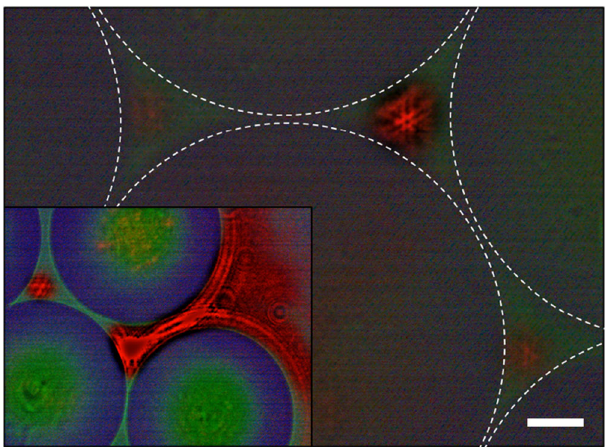
Fig. 2 Optical image of a microlaser fractal transverse mode produced at the intersection of three, 200 μ m diameter polystyrene spheres. The spheres are immersed in a QD solution, L = 370 μ m, and the micrograph is a single pump pulse image recorded with a 20 × objective. The white bar at lower right indicates a length of 25 μ m. The inset is a representative image of laser mode coupling facilitated by increasing the separation between two